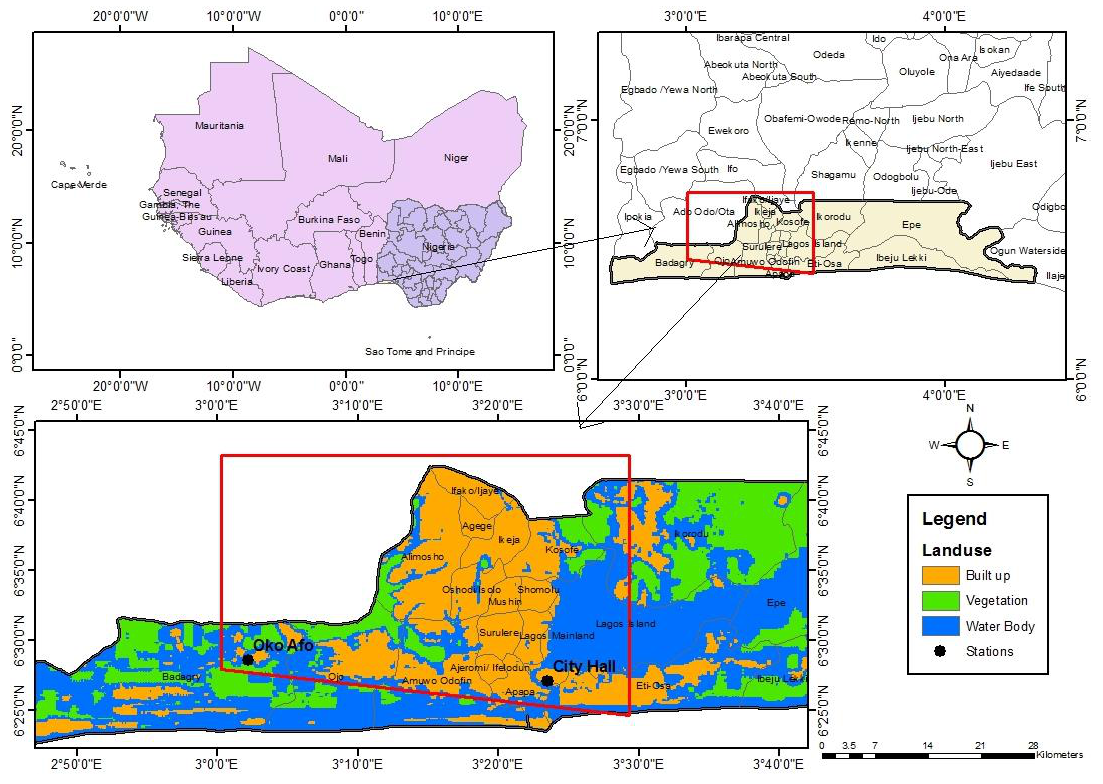
Figure 1. Map of the study location.